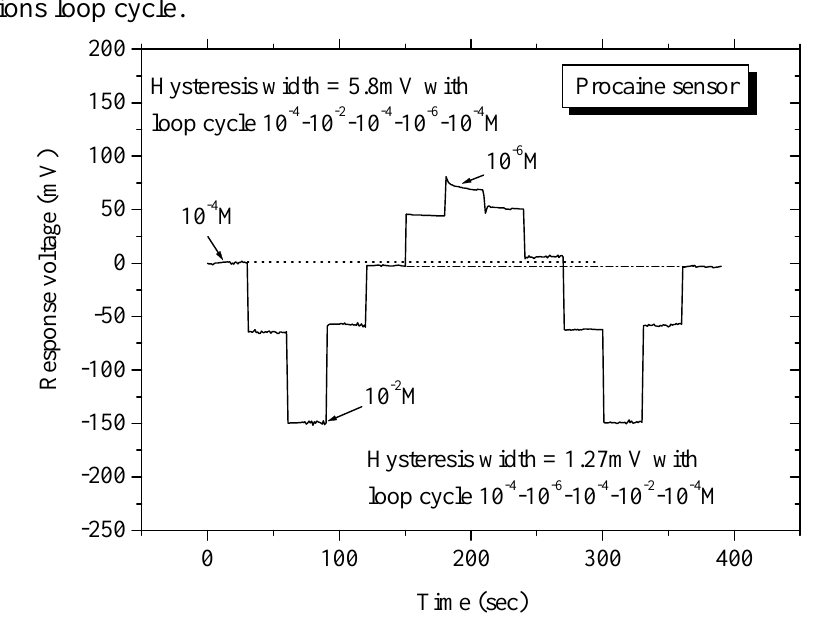
Figure 6. Hysteresis widths of procaine drug sensors based on ruthenium dioxide membrane with the 10 -4 -10 -2 -10 -4 -10 -6 -10 -4 M and the 10 -4 -10 -6 -10 -4 -10 -2 -10 -4 M of procaine concentrations loop cycle.